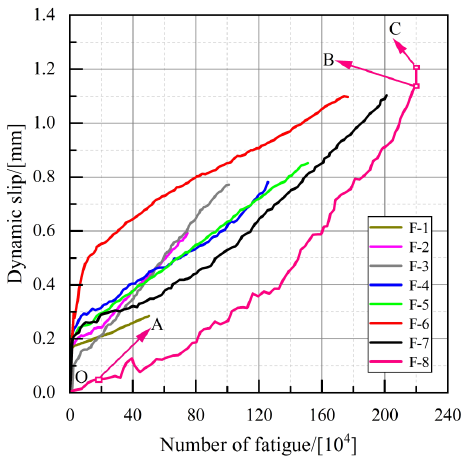
Figure 9. Slip-number of fatigue loading cycle’s curve.